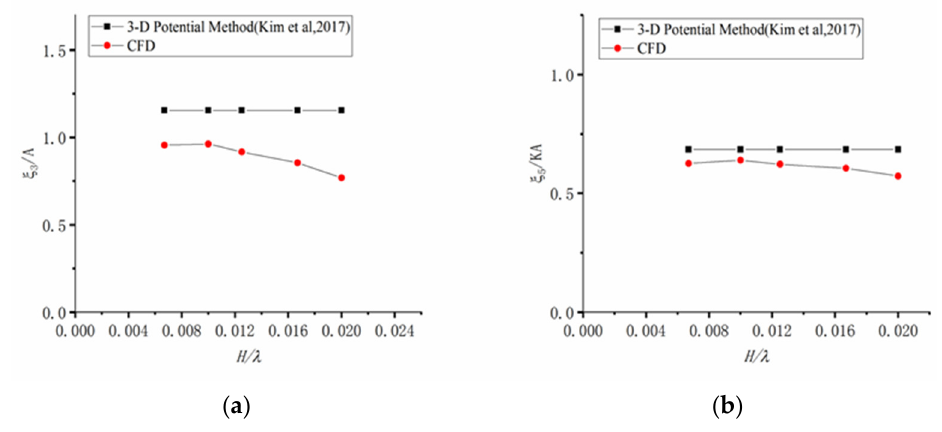
Figure 13. RAOs of KVLCC2 hull for different wave steepness. ( a ) Heave; ( b )